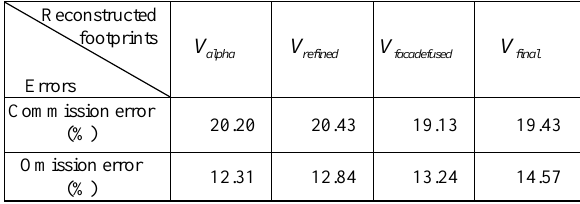
Table 3: Footprint reconstruction